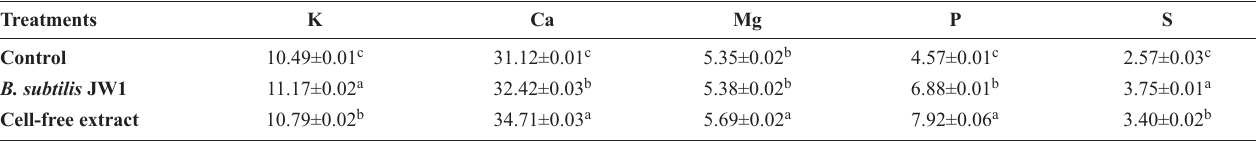
Tab. 3 : Effect of isolate JW1 and bacterial cell free CF on nutrient uptake of Chinese cabbage